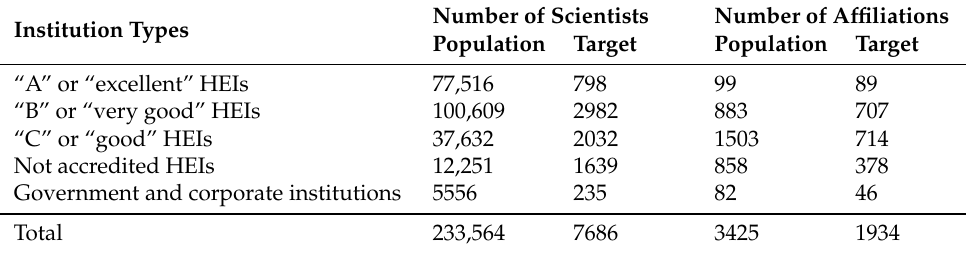
Table 1. Population and sample